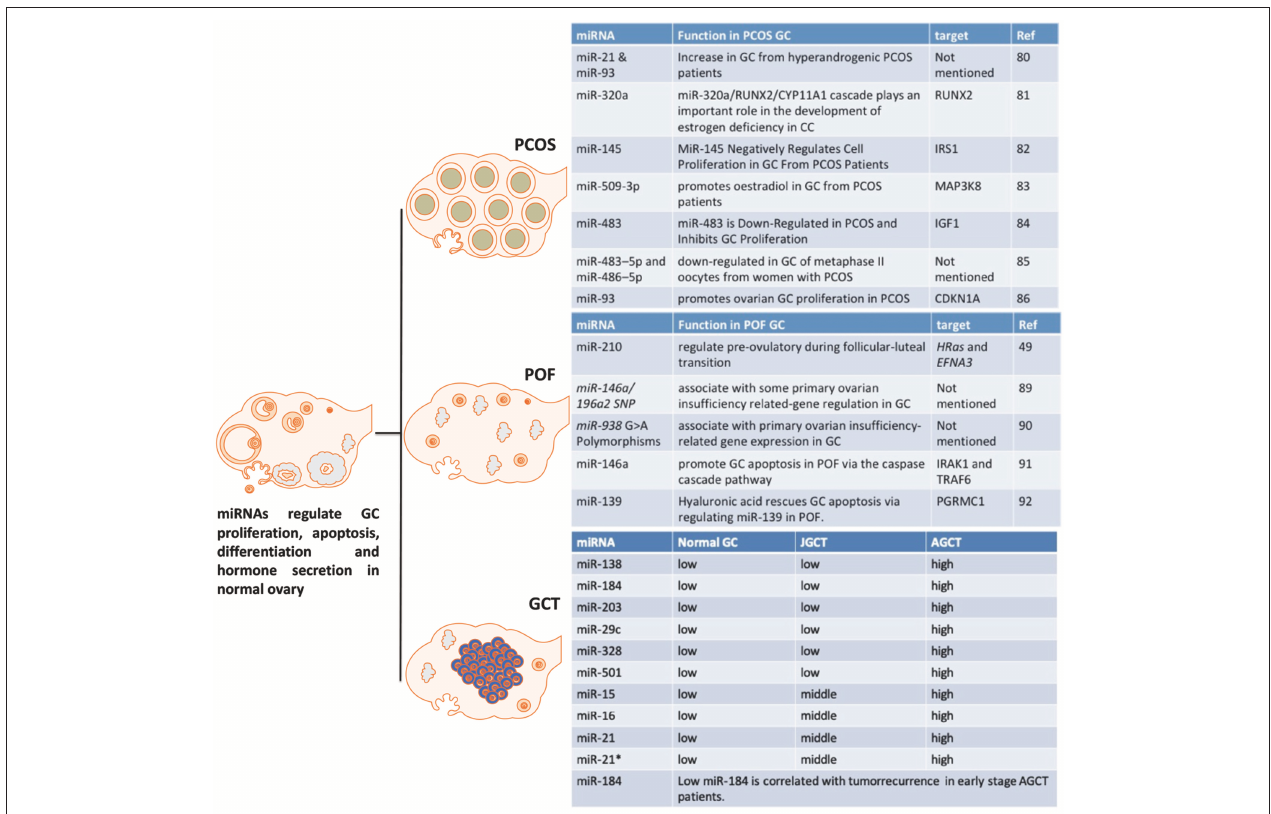
FIGURE 5 | The effect of miRNAs on GC from PCOS, POF and GCT. These miRNAs are potential markers or targets for diagnostic, therapeutic, or prognostic treatment of PCOS, POF, or